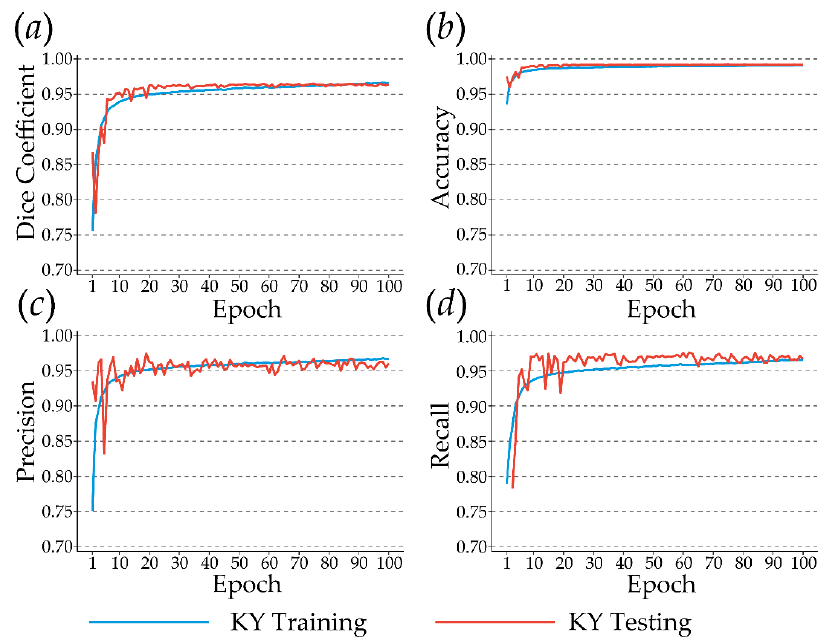
Figure 6. Accuracy metrics by epoch for the KY Training and KY Testing data. ( a ) Dice coefficient or F1 score, ( b ) overall accuracy, ( c ) precision, and ( d ) recall.